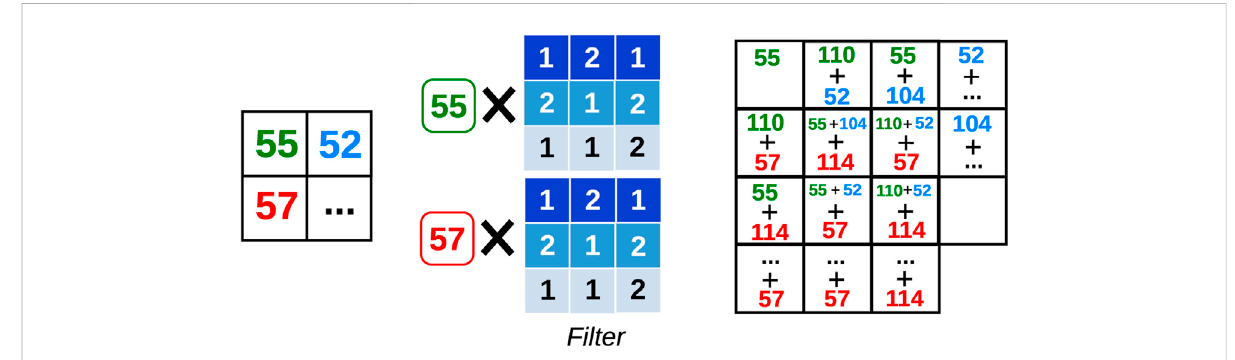
FIGURE 7 Schematic illustration of the 2D-transposed convolution. Each input value, e.g., 55, 57, etc., is multiplied by the entire kernel resulting in a 3 × 3 matrix. These matrices are then added to one another in a sliding and overlapping